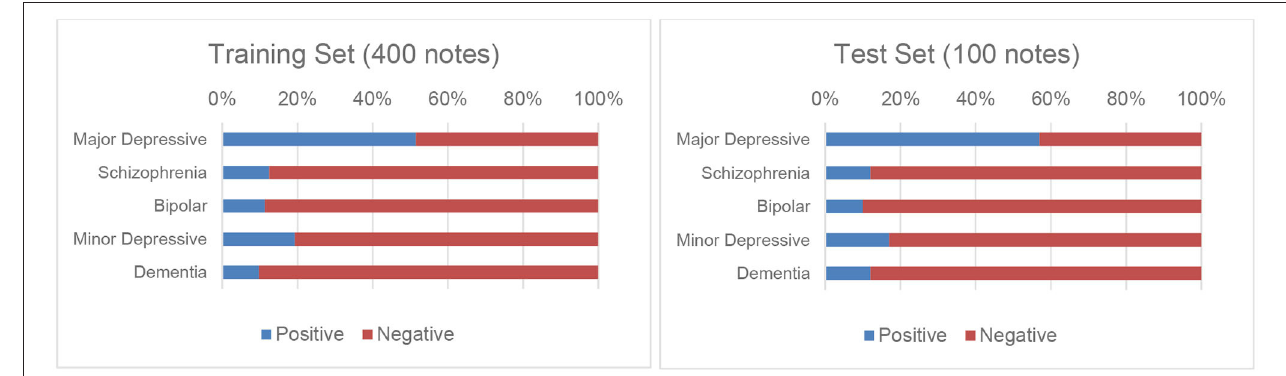
FIGURE 1 | Distributions of the five disorders in the training and test